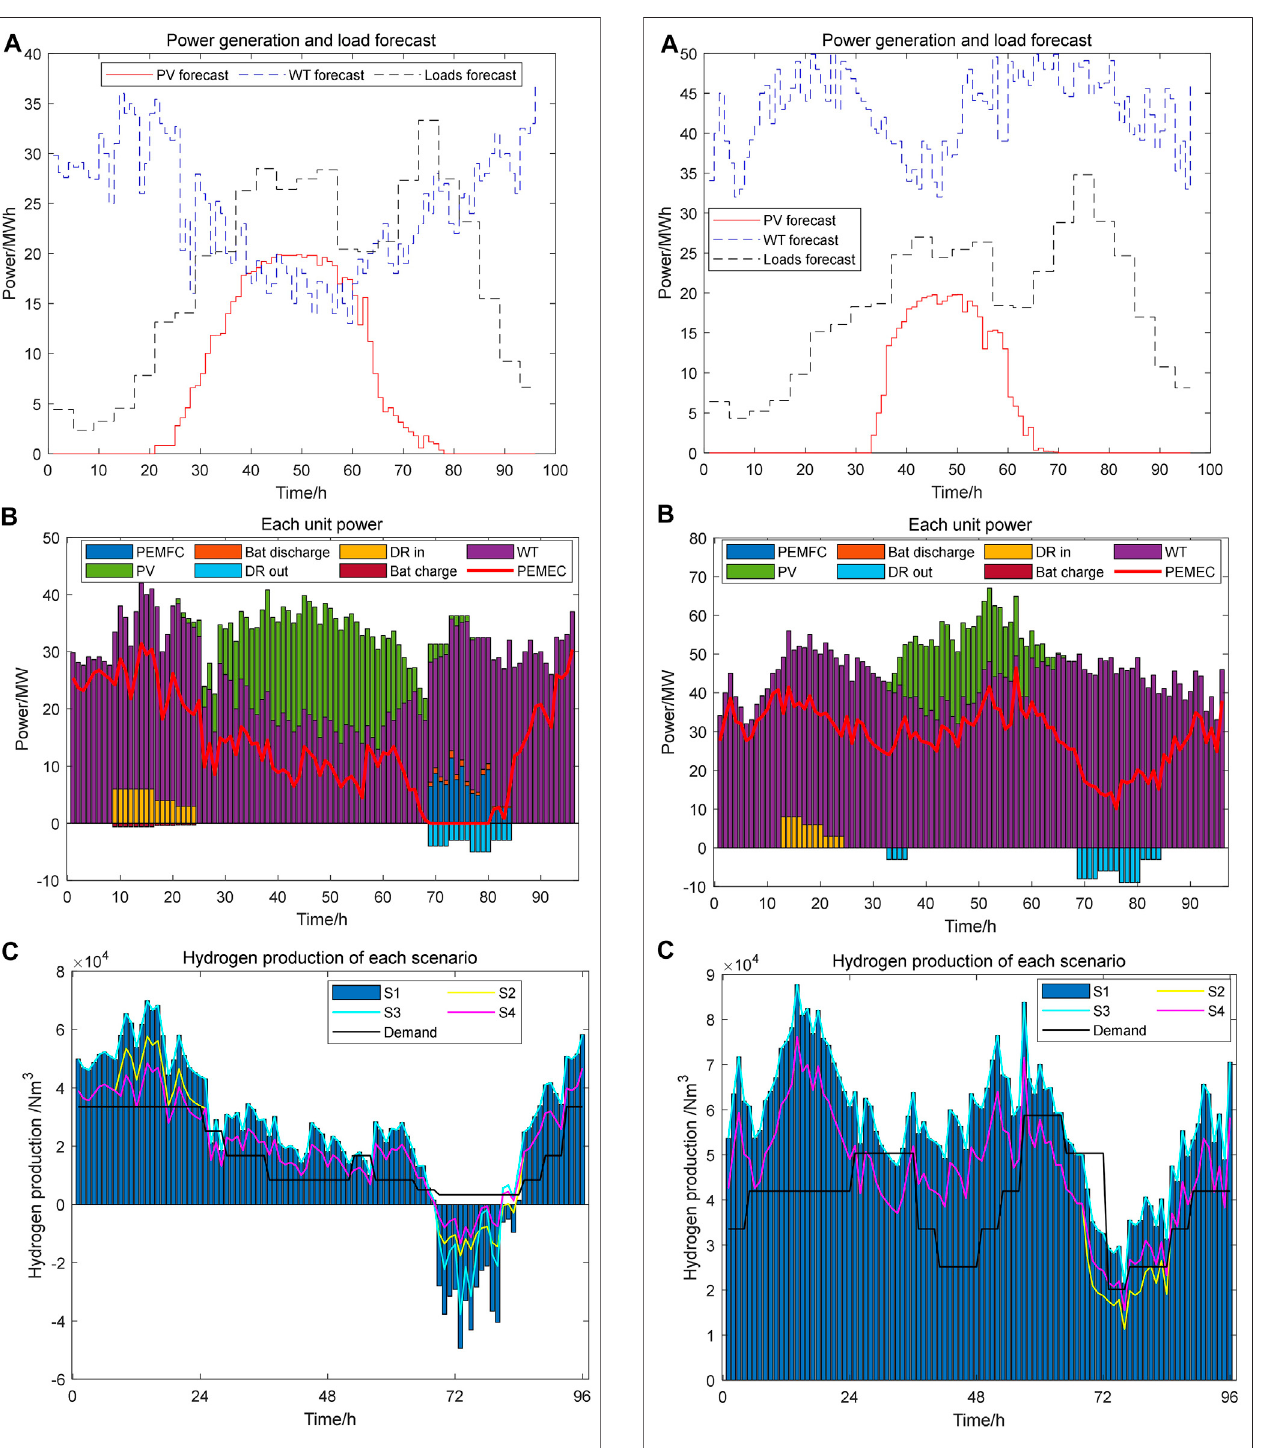
FIGURE 10 | (A) Intra-day forecast results of a typical summer day, (B) each unit power of a typical summer day, (C) hydrogen production and hydrogen demand of a typical summer day.